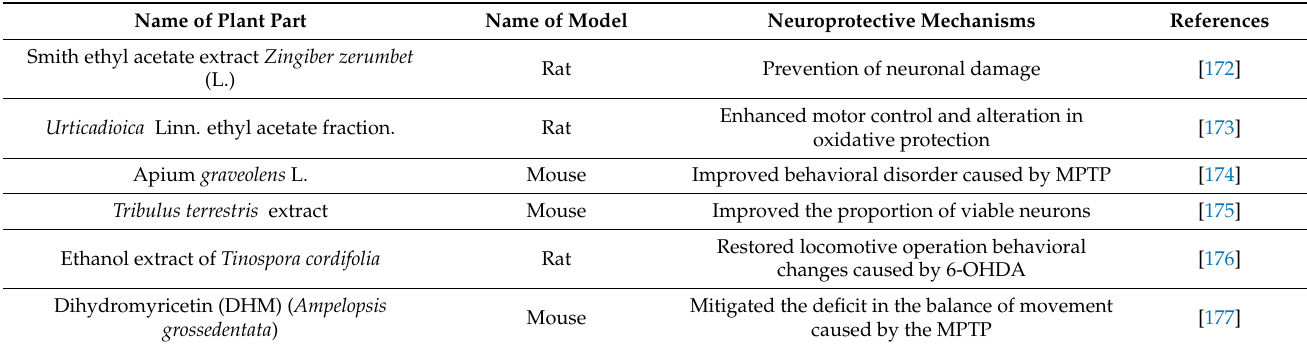
Table 2. Representative natural products and their bioactive substances with neuroprotective activity in the treatment of PD related disease